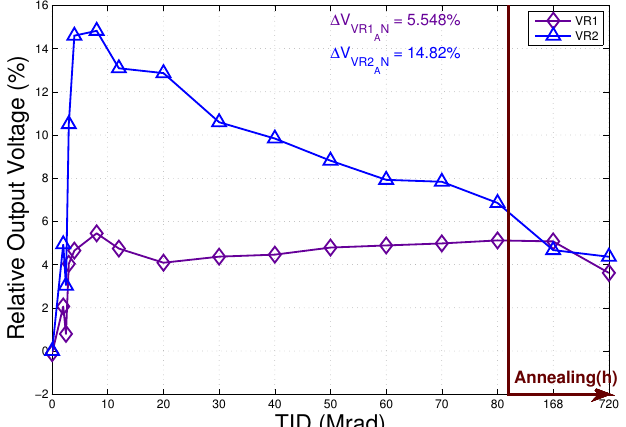
Figure 20. Relative output voltage (%) of the VR1 and VR2 when exposed to Protons and X-rays. The chips were irradiated unbiased with 3 MeV protons in vacuum, up to a total dose of 2 Mrad(Si), followed by three days of annealing. Then they were further irradiated with 10keV X-rays up to 78 Mrad(Si) with a dose rate of 300 rad(Si)/s. The dose reported on the x-axis is the sum of the proton and the subsequent X-ray irradiation which is 80